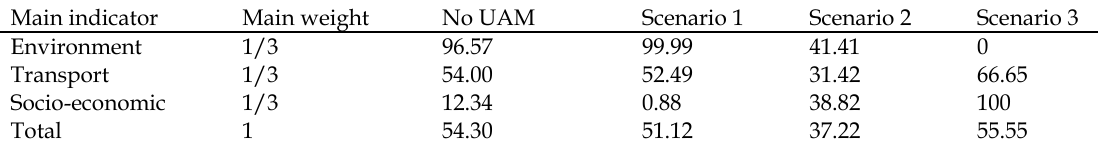
MCDA example results for the case